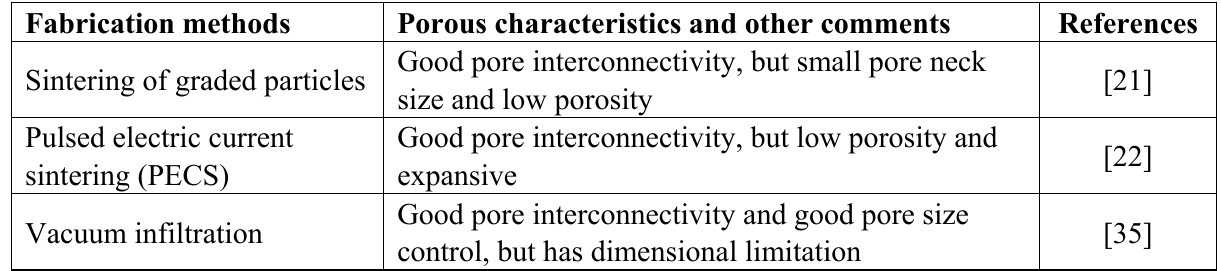
Table 2. Fabrication methods and their